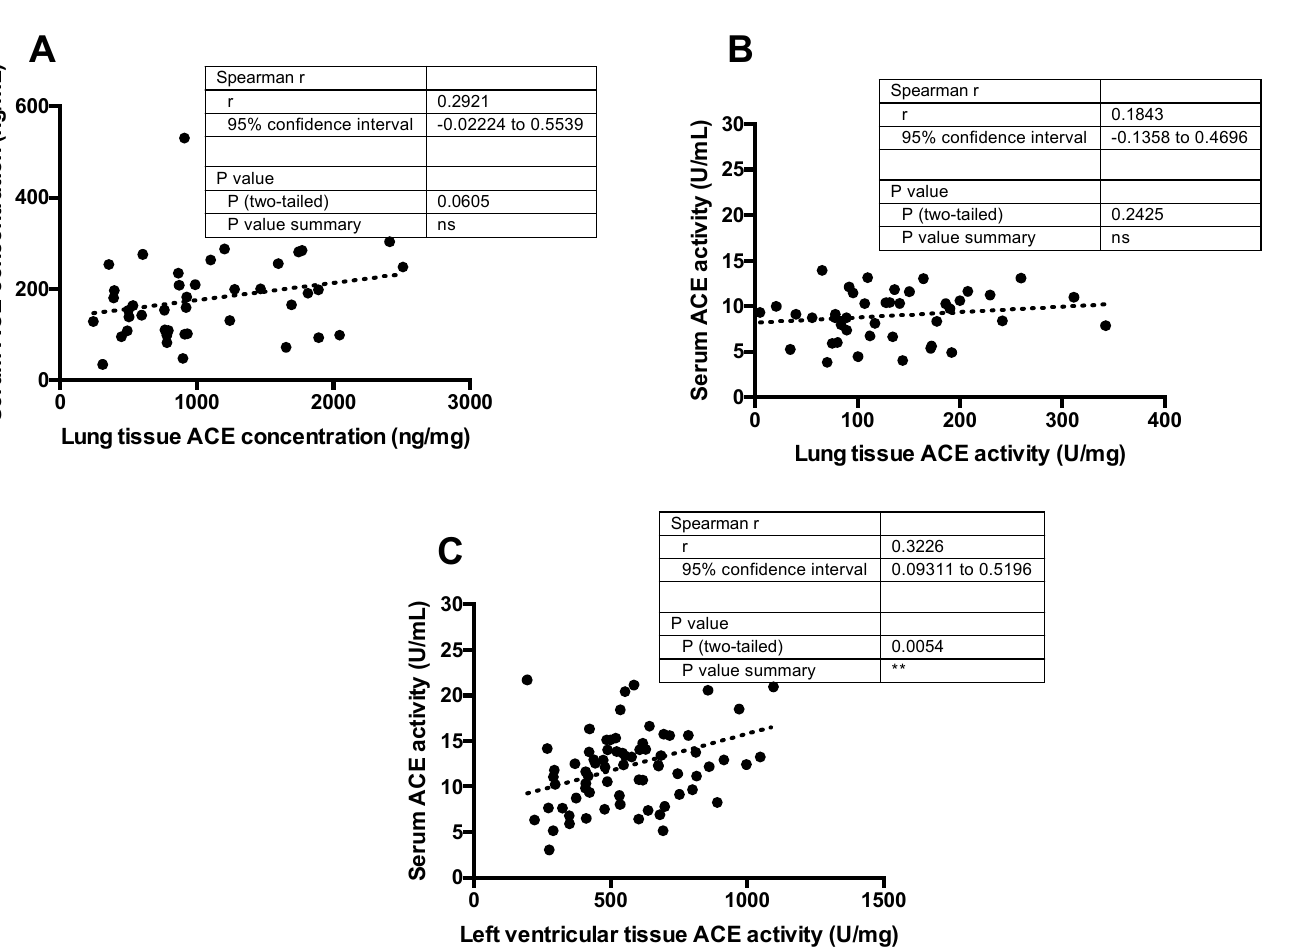
Figure 3. Correlation between circulating and tissue ACE levels in the same patient samples. Serum ACE concentration or activity was plotted as the function of the ACE concentration ( A ) or activity ( B ) in lung tissue homogenates or ACE activity in the left ventricle of explanted human heart tissue samples ( C ). The parameters of Spearman’s correlation are shown in the table inserts (“ns” means no significant correlation, asterisks represent the presence of a statistically significant correlation). Each symbol represents the value determined for an individual patient. The linear fits represented by the dotted lines in the graphs show the trendlines.